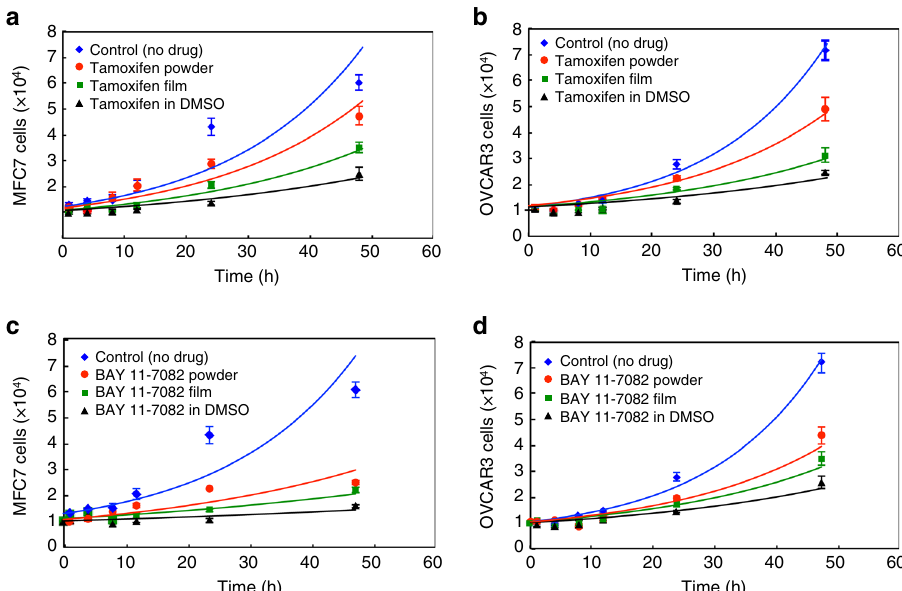
Fig. 8 Cell growth studies. Cell growth pro fi le ( solid line — eye guide): a MCF7 cells treated tamoxifen, ( b ) OVCAR3 cells treated with tamoxifen, ( c ) MCF7 cells treated with BAY 11-7082, ( d ) OVCAR3 cells treated with BAY 11-7082. All data points in the plots are an average of at least three fi lm samples ± standard